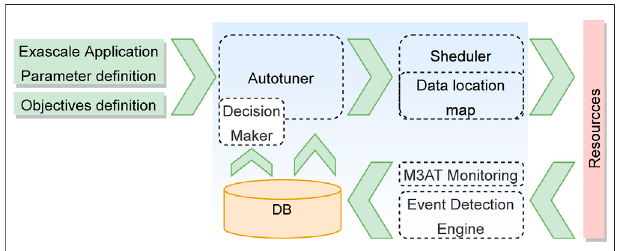
FIGURE 1 | Data fl ow diagram of the autotuning